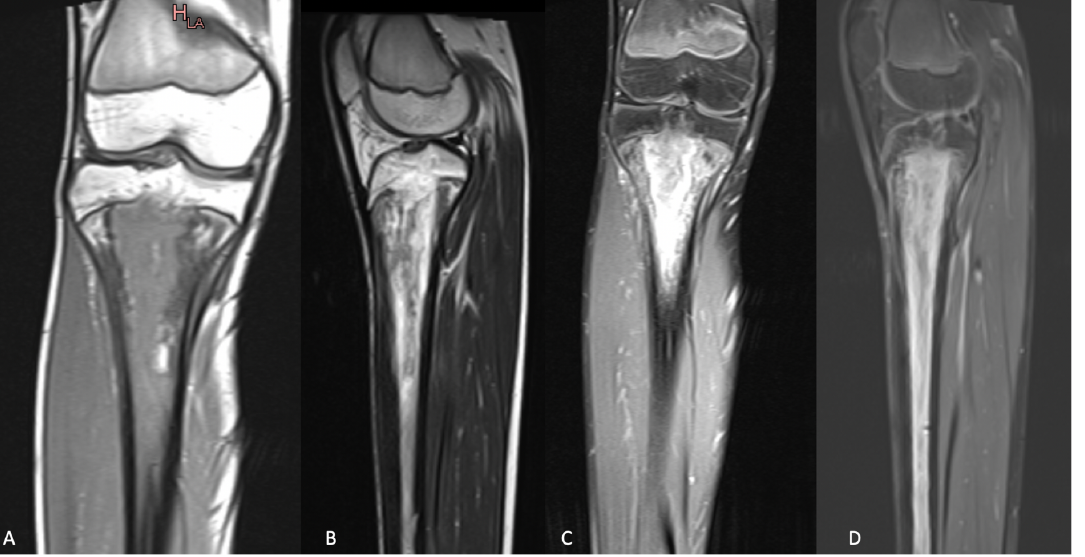
Figure 1. MRI of the right knee showing primary metaphyseal acute hematogenous osteomyelitis with secondary pandiaphyseal and transphyseal extension due to methicillin sensitive S. aureus, producer of the Panton-Valentin Leucocidin: ( A ) coronal view of the right knee with T1 sequence; ( B ) sagittal view of the right knee with T2 sequence; ( C ) coronal view of the right knee with T1 sequence and Gadolinium; ( D ) sagittal view of the right knee with T1 sequence and Gadolinium.